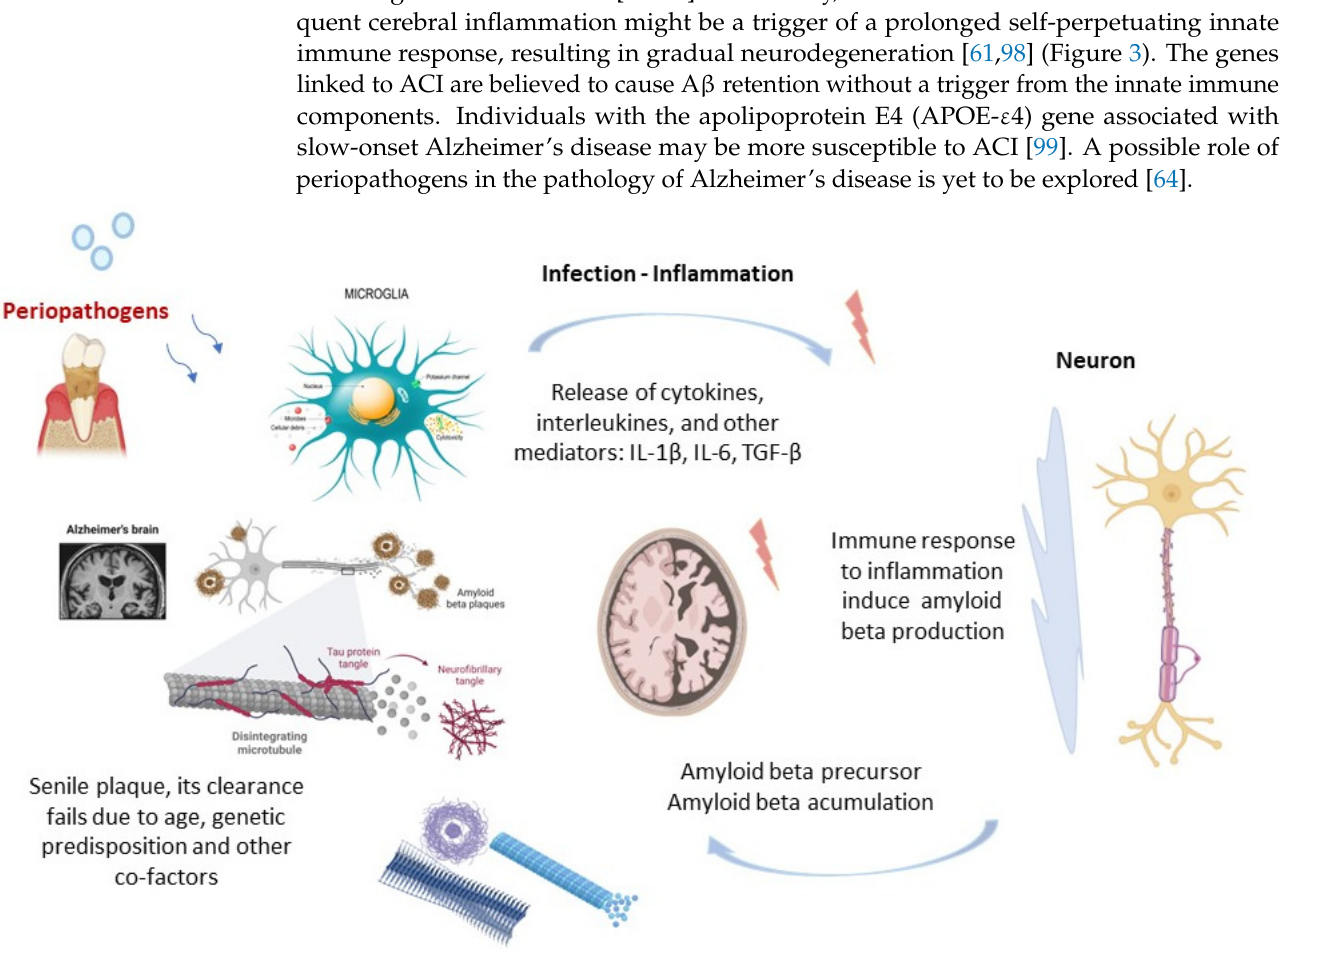
Figure 3. Hypothetical mechanism of the neural pathological changes associated with chronic periodontal inflammation [65], Biorender platform. The potential suggested primary role of periodontal pathogens, inflammatory mediators, local and systemic immune response, with a subsequent induction of amyloid beta formation and senile plaque accumulation in the central nervous system.